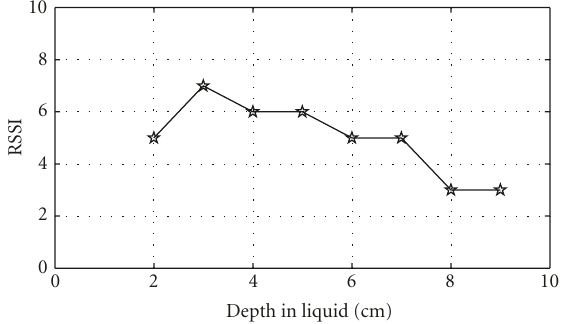
Figure 5: RSSI versus Depth in liquid.